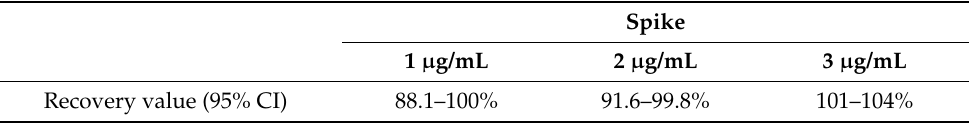
Table 4. Determination of accuracy for the HPAEC-PAD method: spike recovery values at different spike